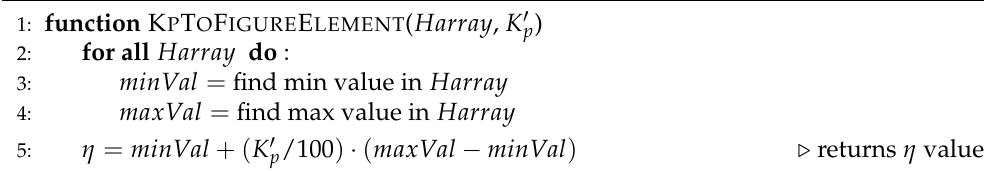
Algorithm 1 Algorithm of calculating the size of a graphic primitive in the UGVA notation.